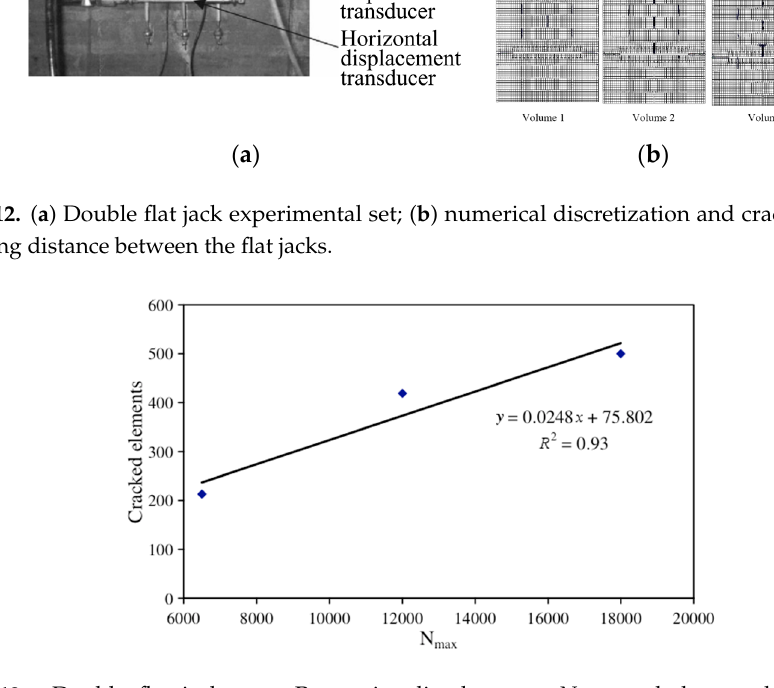
Figure 13. Double flat jack test: Proportionality between N max and the number of cracked finite elements.